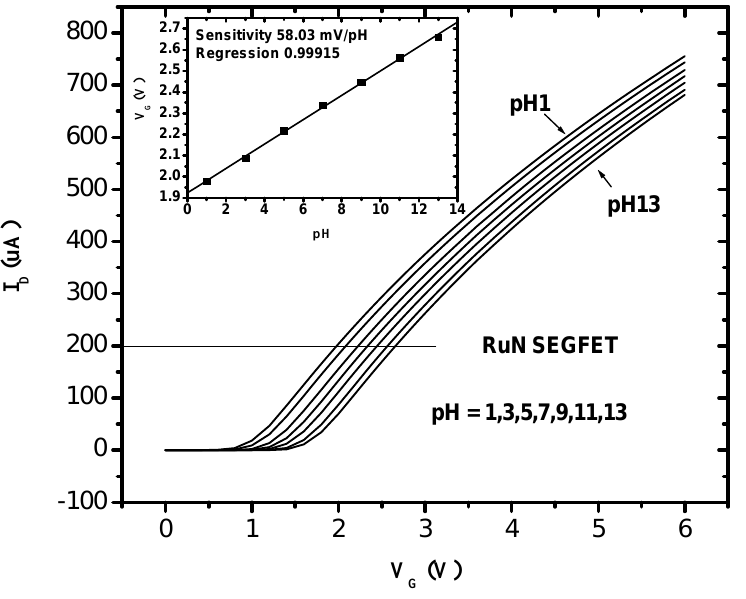
Figure 5. I-V and sensitivity curves of ruthenium nitride thin film pH